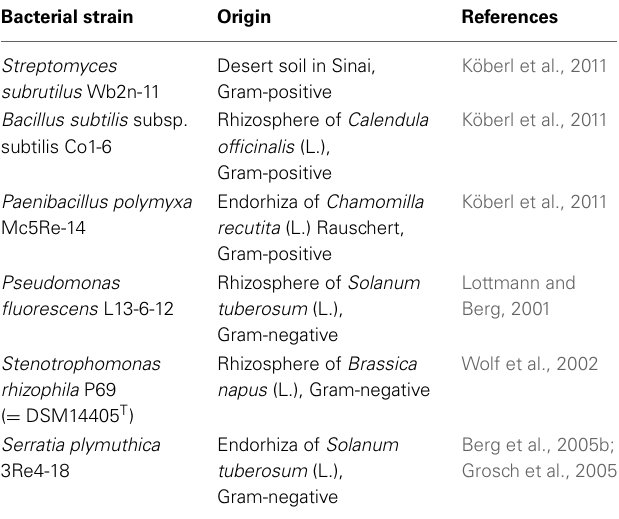
Table 2 | Bacterial strains used in this